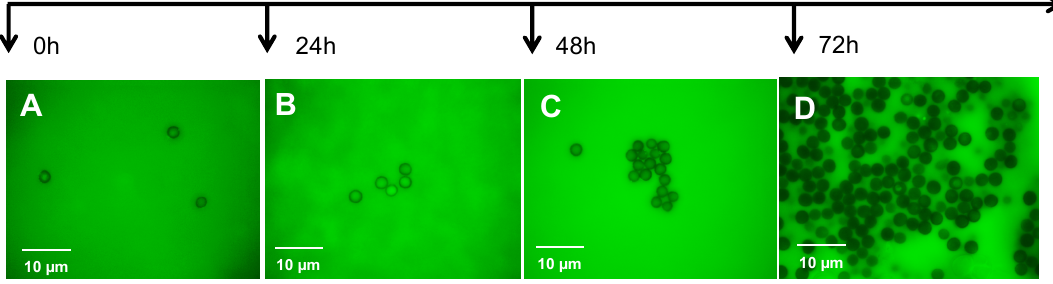
Figure 3. Quorum sensing of smut teliospores via the action of its own arginase that was secreted into the Lilly–Barnett medium. The degree of cytoagglutination was displayed after 0 h ( A ), 24 h ( B ), 48 h ( C ), and 72 h ( D ) of incubation.